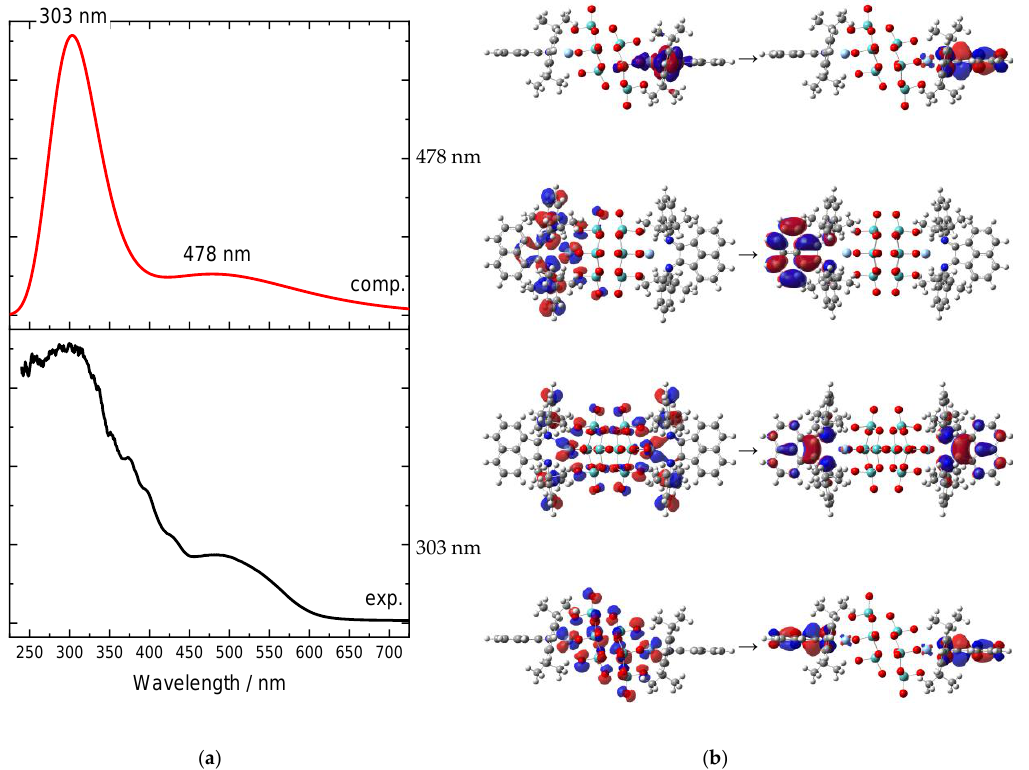
Figure 5. ( a ) Experimental (black line) and computed UV–Vis absorption spectra (red line) of complex 1 in the wavelengths’ region from 250 to 700 nm. No scale factor applied. ( b ) Natural transition orbital (NTO) analysis of the main transitions corresponding to the two electronic bands; two perspectives are depicted for each transition. Calculations were performed on the optimized geometry.